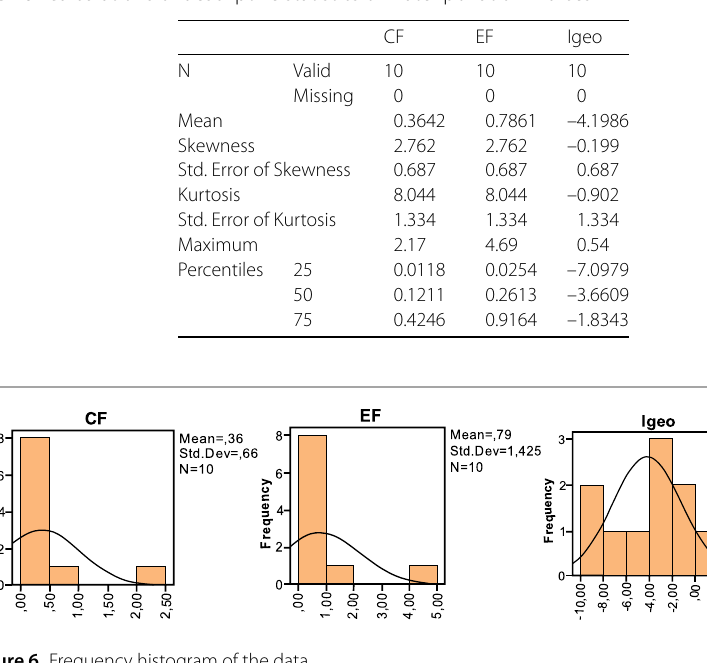
Geo-accumulation Index: ( 0 ≤ FE-Igeo to low